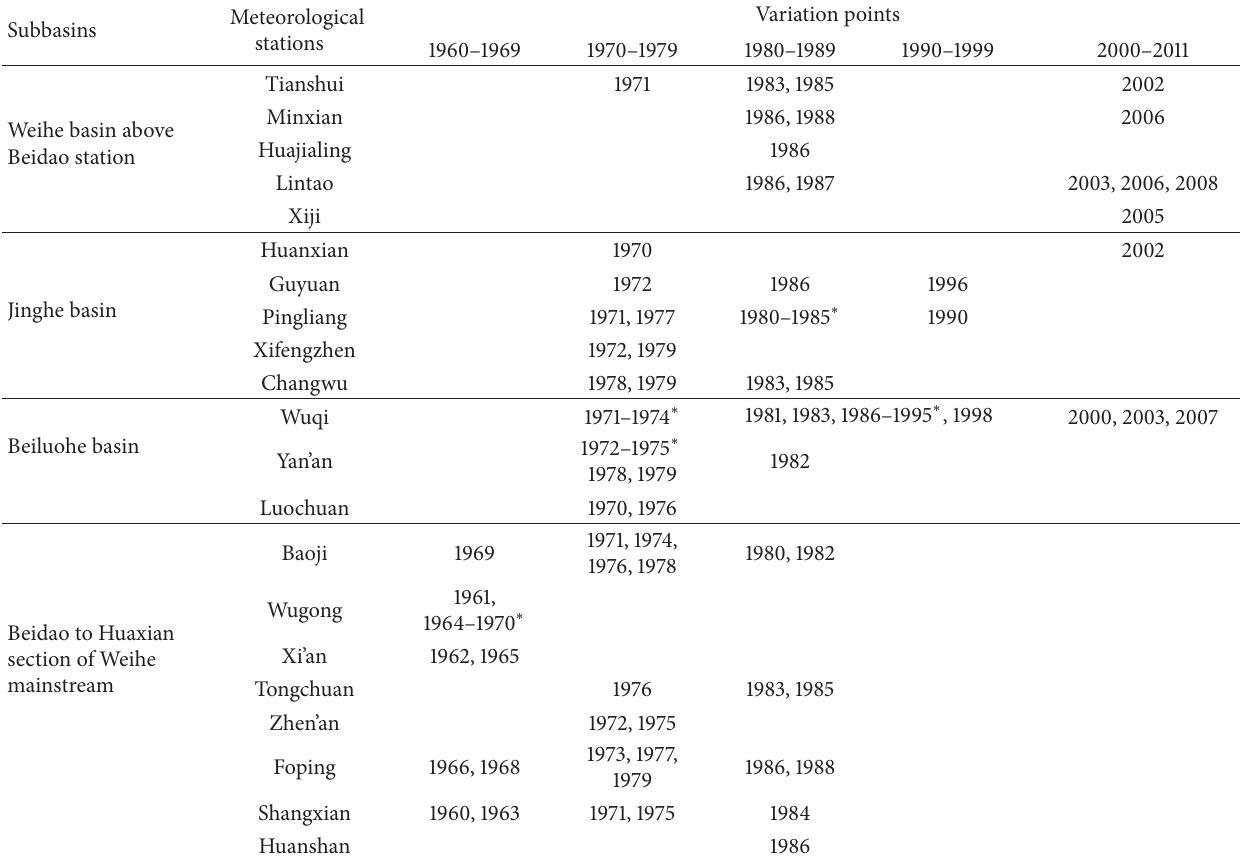
Table 4: Variation points in annual precipitation trends in the Weihe